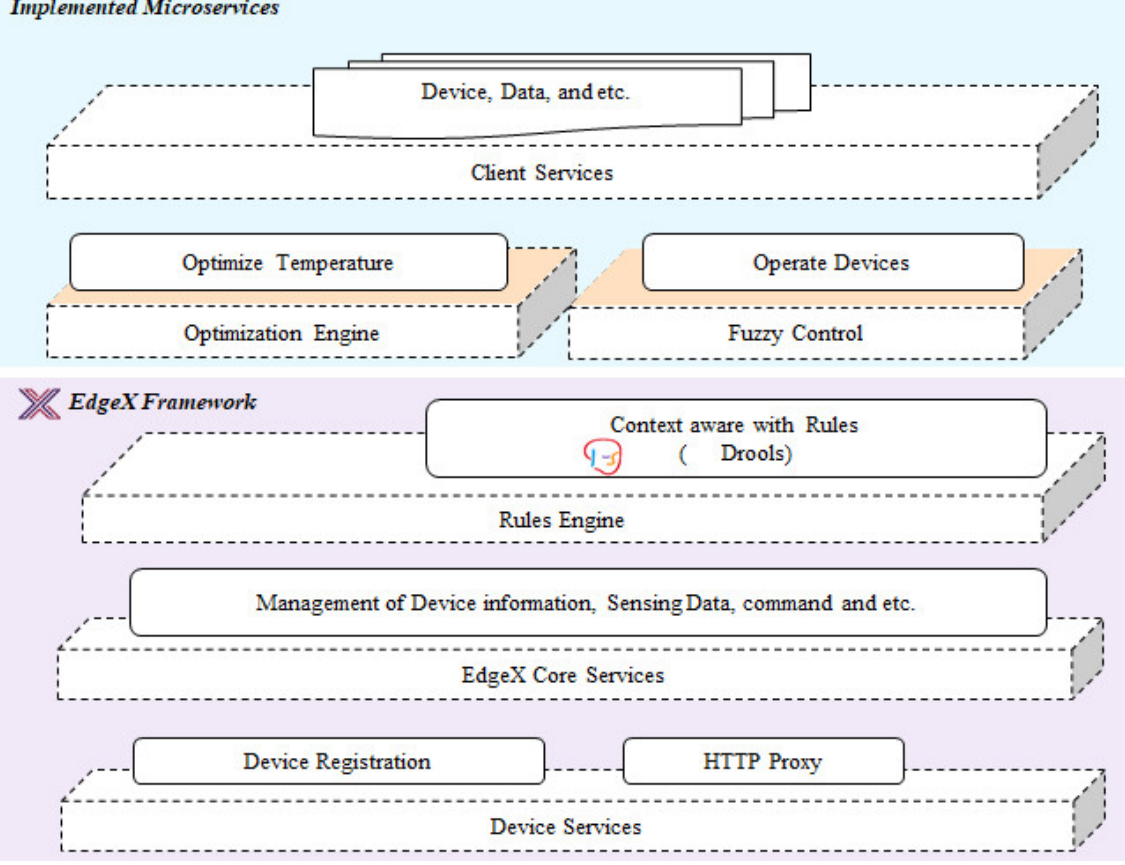
Figure 9. Developed Functionalities of the Intelligent Edge Computing Platform Using